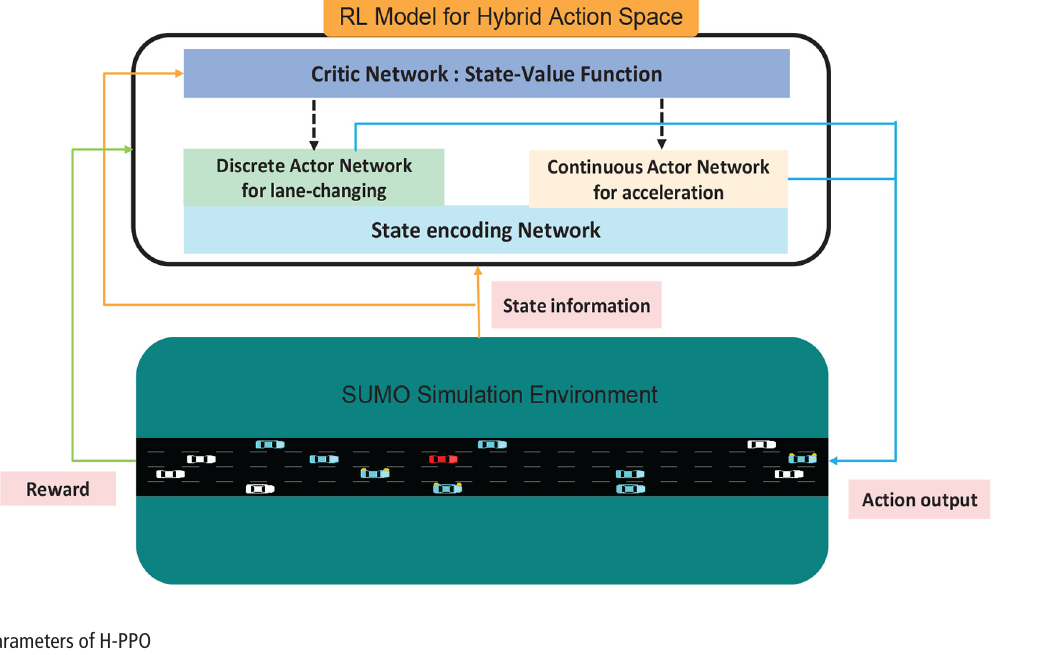
Figure 2 Eco-driving system architecture based on RL in hybrid action space